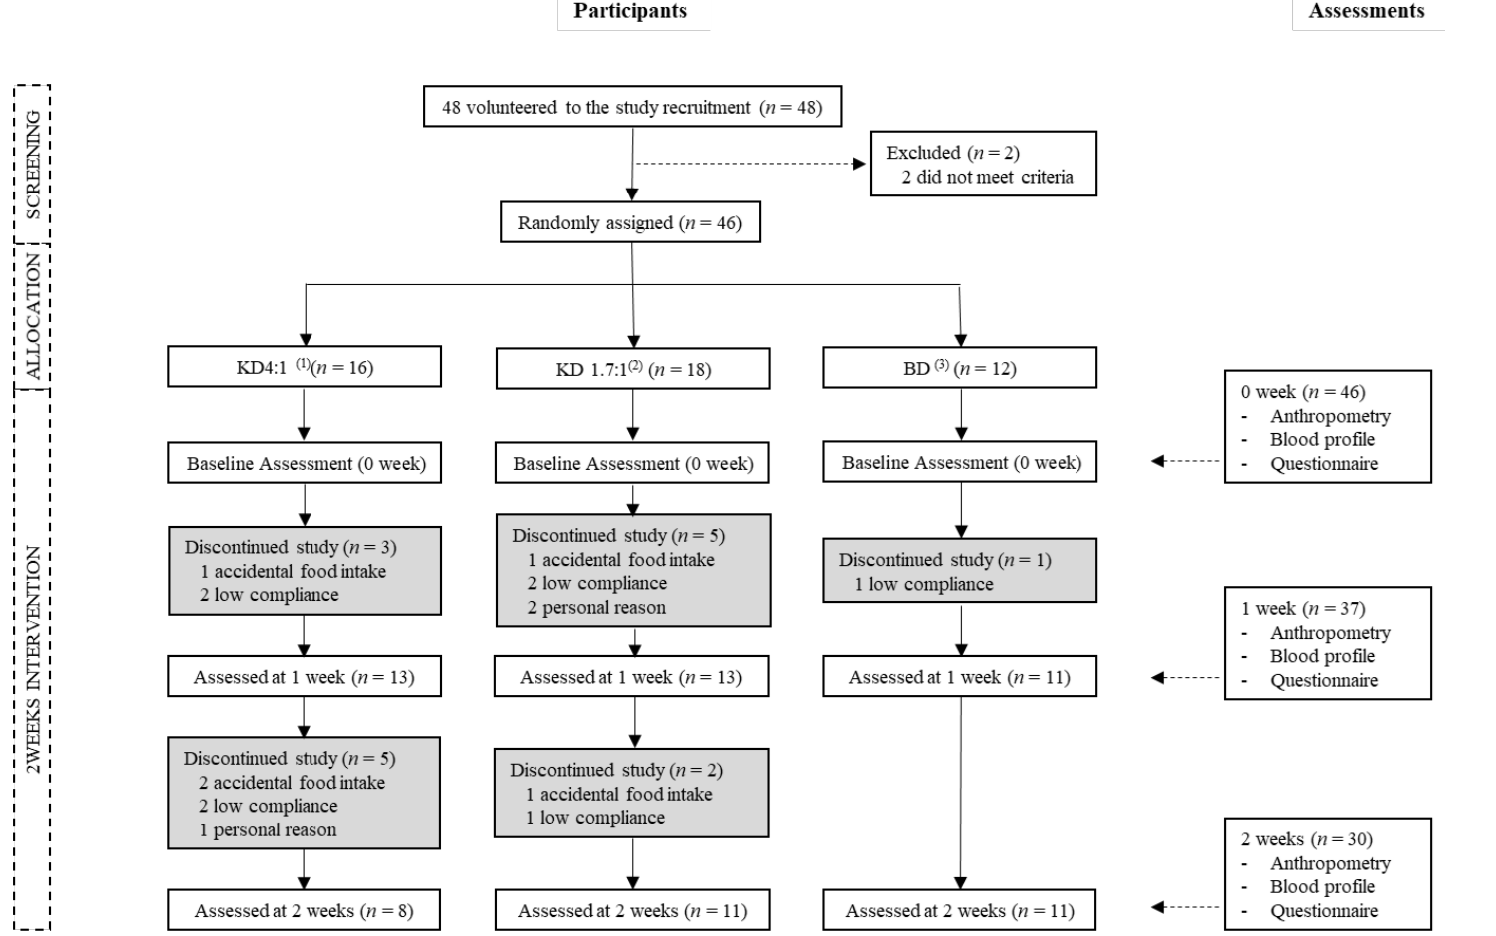
Figure 1. Diagram of study flow. (1) KD4:1 = Ketogenic nutrition drink 4:1 (Ketonina, Namyang Dairy Product Co Ltd., Seoul, Korea). (2) KD1.7:1 = Ketogenic nutrition drink 1.7:1 (Product for research, Maeil Dairies Co Ltd., Gyeonggi-doKorea). (3) BD = Balanced nutrition drink (Mediwell Nutty flavor, Maeil Dairies Co Ltd., Gyeonggi-do, Korea).